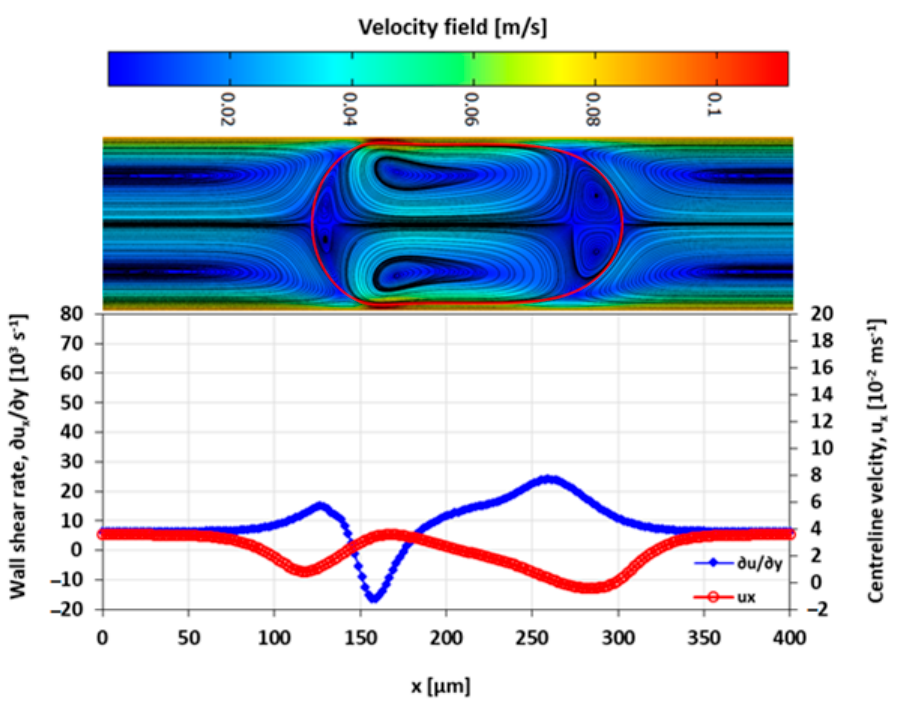
Figure 18. Wall shear rate and the x-velocity at centreline ( 𝑦 = ℎ/2 ) for 𝜆 = 0.5 and 𝐶𝑎 = 0.03 .